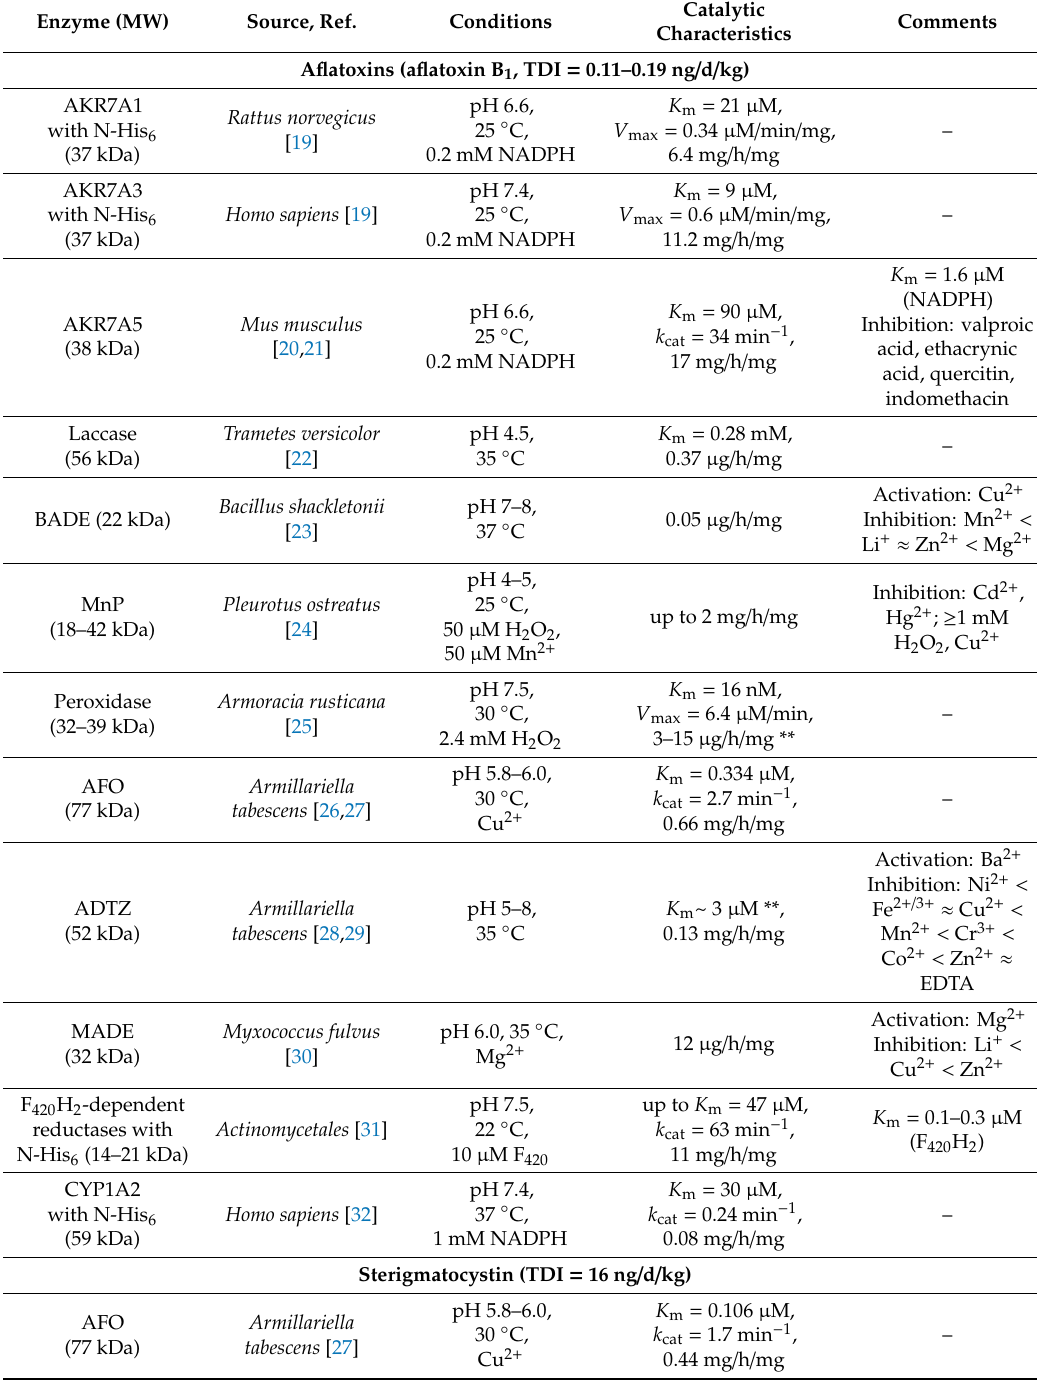
Table 1. Enzymes detoxifying mycotoxins and their properties. Molar weight (MW) of enzymes corresponds to the value issued in the article or presented in the UniProt database. Optimal or used conditions for determination of enzyme activity are listed. Catalytic characteristics of enzymes are shown towards specified mycotoxin, if not stated otherwise. Tolerable daily intake (TDI)* of mycotoxins is listed for referential purpose and could vary widely depending on the local